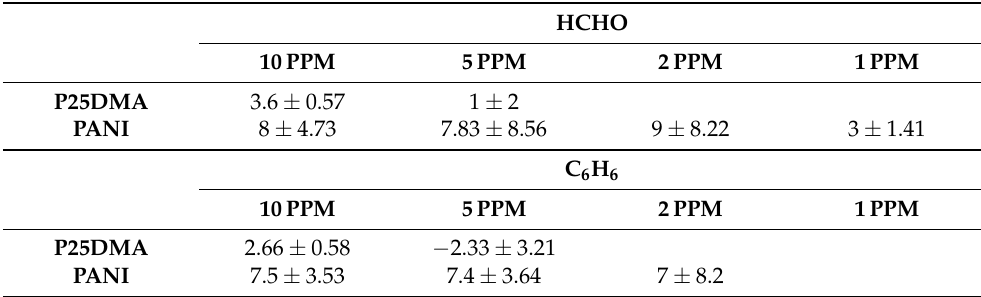
Table 2. The mean and standard deviation of the detection voltage, in mV, for combinations of detector polymers and test